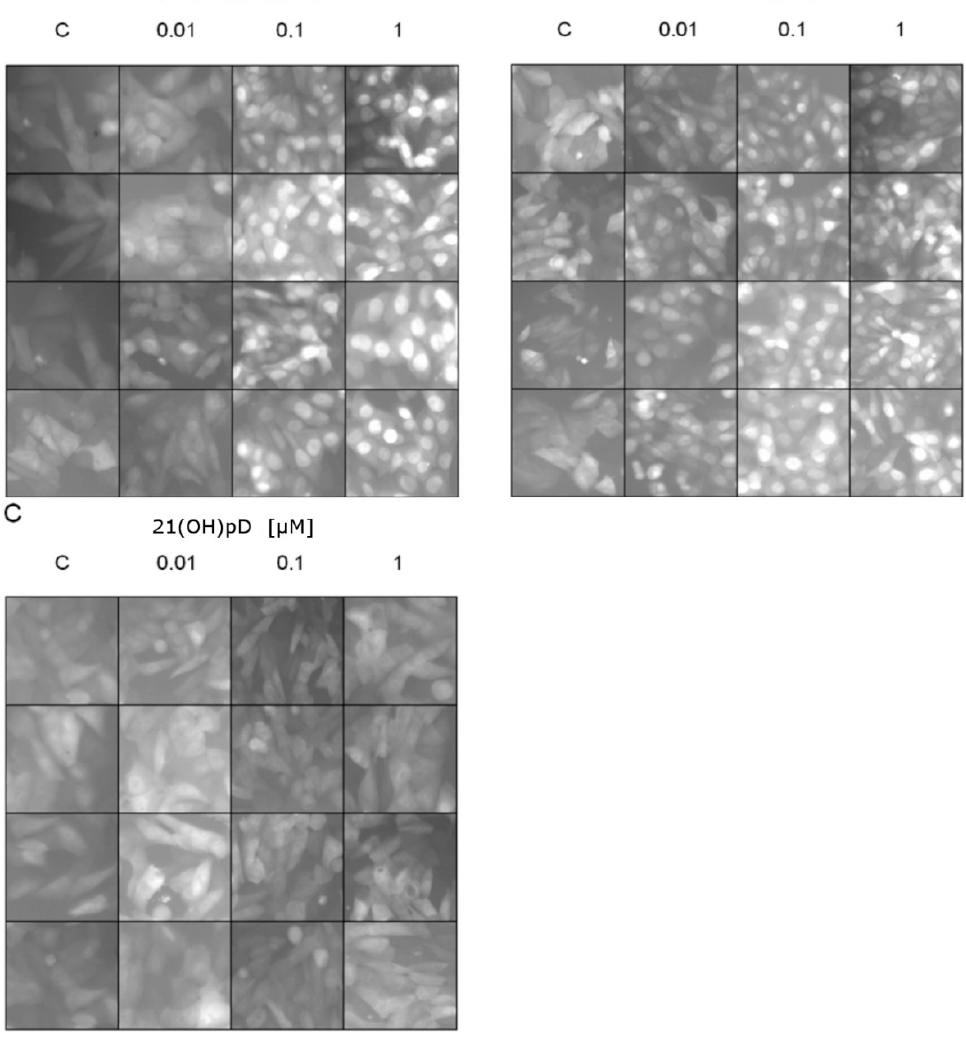
Figure 7. Effects of vitamin D analogs: ( A ) 1,25(OH) 2 D 3 , ( B ) calcipotriol or ( C ) 21(OH)pD 3 at 0 (C—control), 0.01, 0.1 or 1 µ M concentrations on VDR translocation to the nucleus (green fluorescence shown in a gray scale). Melanoma A375 cells were transduced using pLenti-CMV-VDR-GFP-pgkpuro construct: see Materials and Methods. Vitamin D analogs except 21(OH)pD induce VDR translocation to the nucleus after 1 h of incubation in a concentration-dependent manner. Each panel shows four random micrographs for each concentration taken by fluorescent microscope under 100 ×